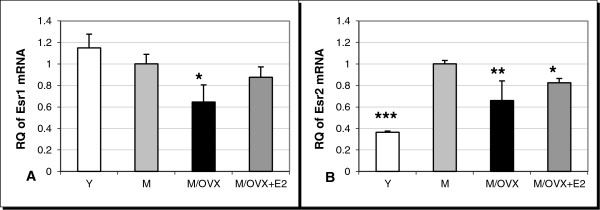
Age- and ovarian hormone-dependent regulation of mRNA expression of estrogen receptors in the rat frontal cortex. We measured age- and hormone-dependent changes by TaqMan-based quantitative real-time PCR in mRNA expression of Esr1 (A) and Esr2 (B), encoding ERα and ERβ, respectively. Error bars show SD of six independent measurements. Asterisks indicate changes with statistical significance: *corresponds to 0.01<P < 0.05, ** to 0.001<P < 0.01 and *** to P < 0.001. Y, young rat; M, middle-aged female rat; M/OVX, middle-aged ovariectomized (OVX) rat; M/OVX+E2, middle-aged OVX rat with 17β-estradiol (E2) replacement.